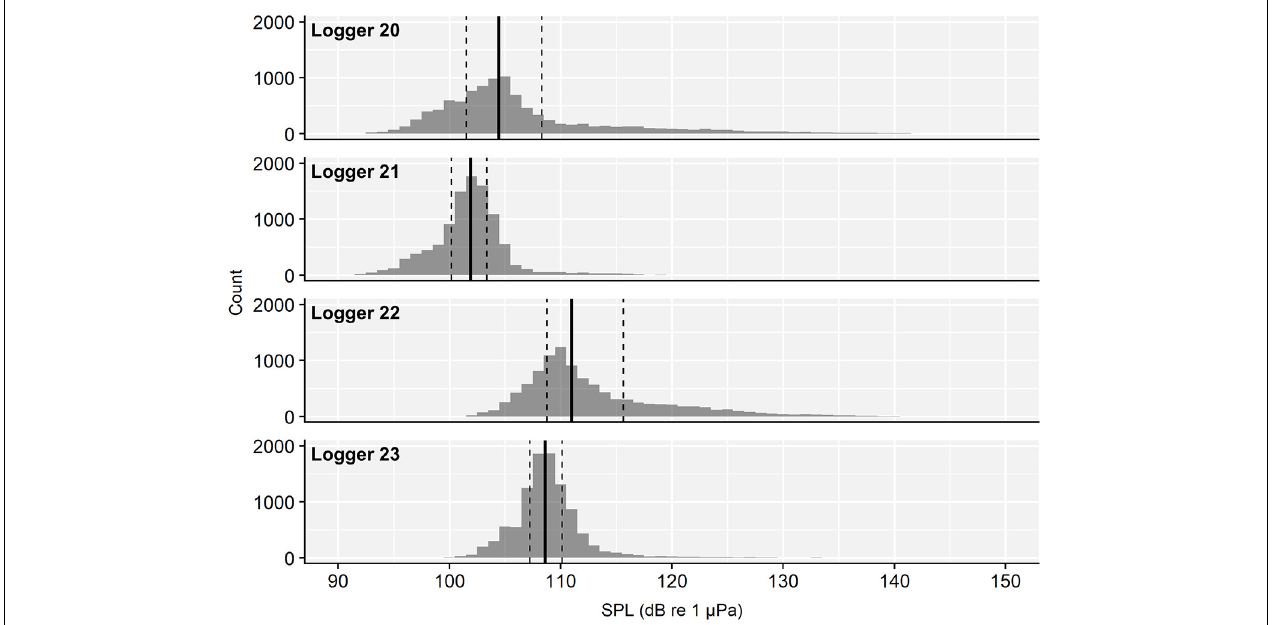
FIGURE 4 | One-minute average 10–10,000 Hz broadband SPL histograms of all four loggers from the entire study period. The solid black line represents the median and the dashed black lines the first and third quartiles.